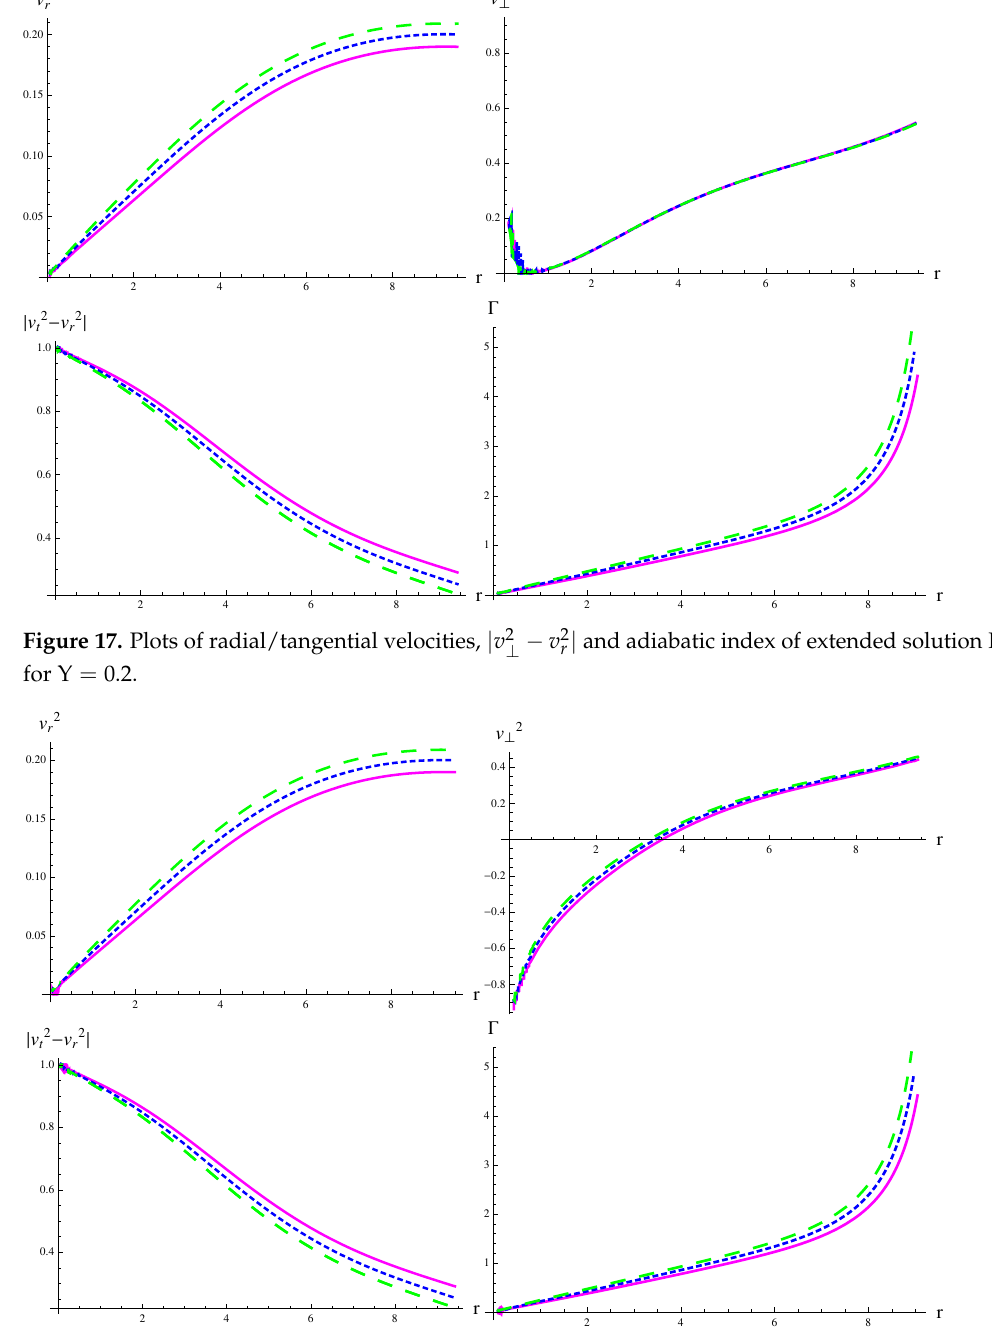
Figure 18. Plots of radial/tangential velocities, | v 2 ⊥ − v 2 r | and adiabatic index of extended solution II for Υ =